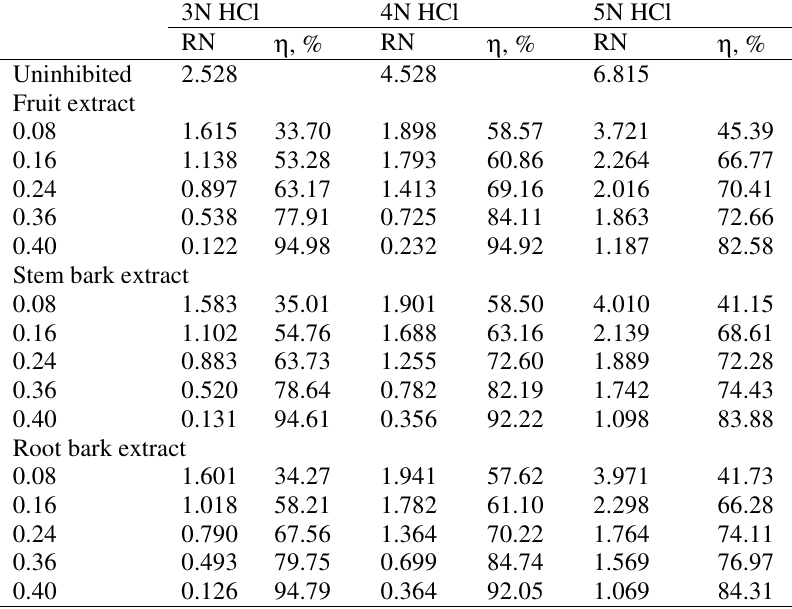
Table 5 . Reaction number and inhibition efficiency for aluminium in hydrochloric acid solution with given inhibitor addition at room temperature for Capparis